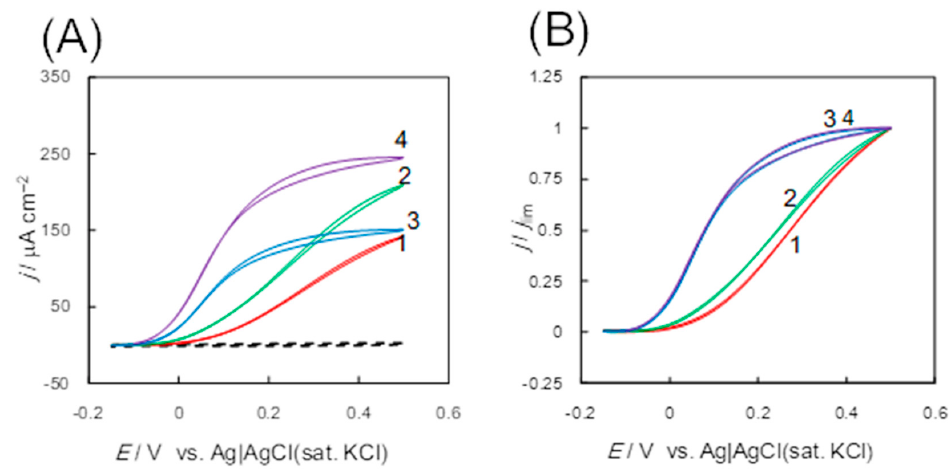
Figure 10. Original ( A ) and normalized ( B ) cyclic voltammograms (CVs) of D -fructose oxidation at Au electrodes on the surface that had been adsorbed the D -fructose dehydrogenase variants; the recombinant FDH (1, red), Δ 1 c_ FDH (2, green), Δ 1 c 2 c_ FDH (3, blue), and M450Q Δ 1 c_ FDH (4, purple) in a McIlvaine buffer (pH 4.5) containing 0.1 M D -fructose under anaerobic conditions at a scan rate ( v ) of 10 mV s − 1 . The dashed line in panel ( A ) represents a background voltammogram obtained using a bare Au electrode. Reprinted from [28], Copyright (2019), with permission from Elsevier.